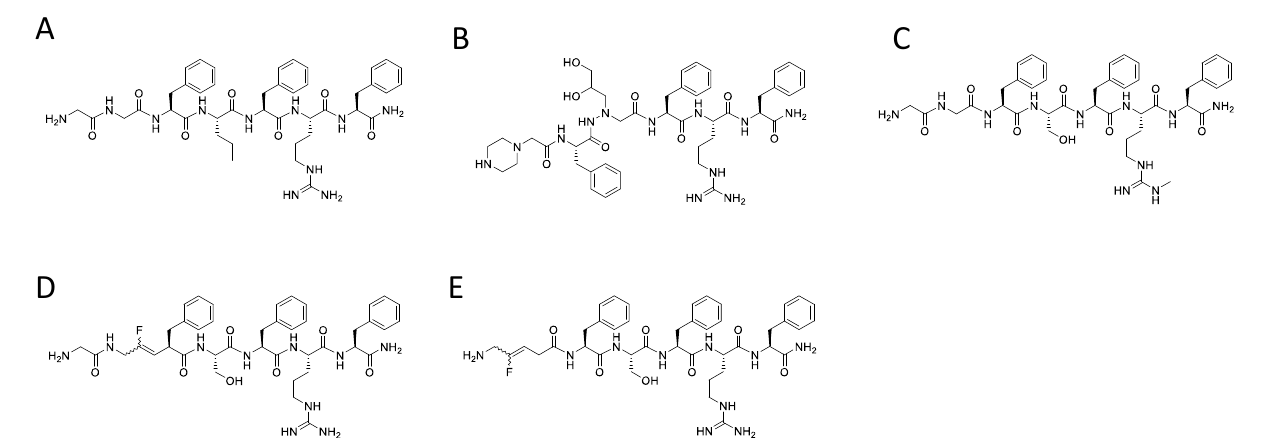
Figure 2. Chemical structures of peptidic and pseudopeptidic human QRFPR ligands. ( A ) [Nva 23 ]26RFa (20–26) (LV-2073); ( B ) [Cmpi 21 , aza- β 3 -Hht 23 ]26RFa (21–26) (LV-2172); ( C ) [(Me) ω Arg 25 ]26RFa (20–26) (LV-2186); ( D ) [ ψ (CF=CH) 21,22 ]26RFa (20–26) ; ( E ) [ ψ (CF=CH) 20,21 ]26RFa (20–26) .